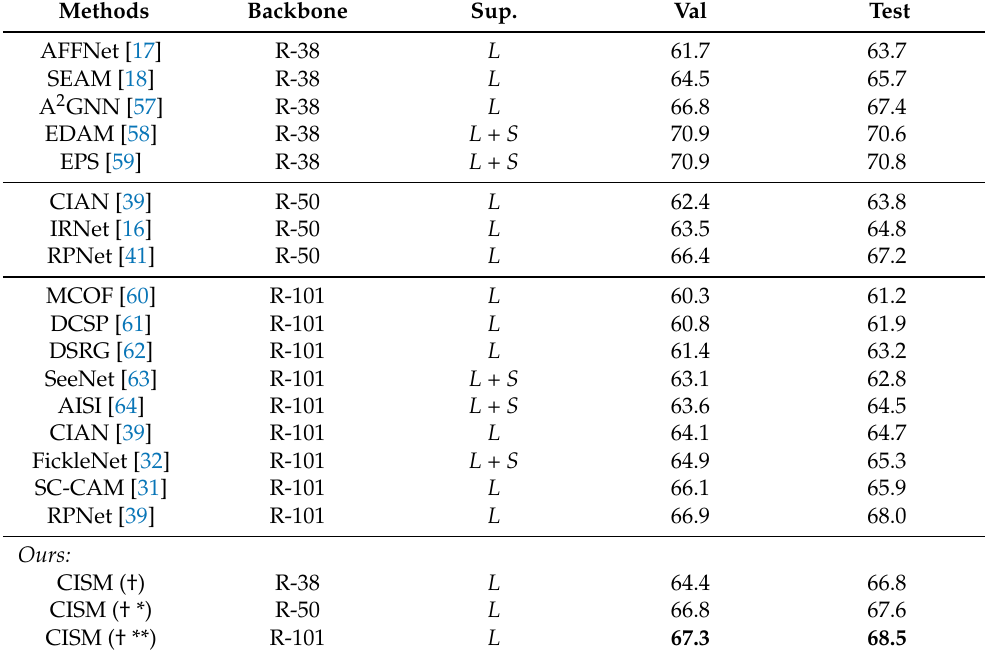
Table 3. The performance statistics of the current state-of-the-art on PASCAL VOC2012. We evaluated the CISM model with different backbone networks and signify these with various combinations of the symbols * and †. These different backbone networks include: ResNet38 (†); ResNet-50 (†